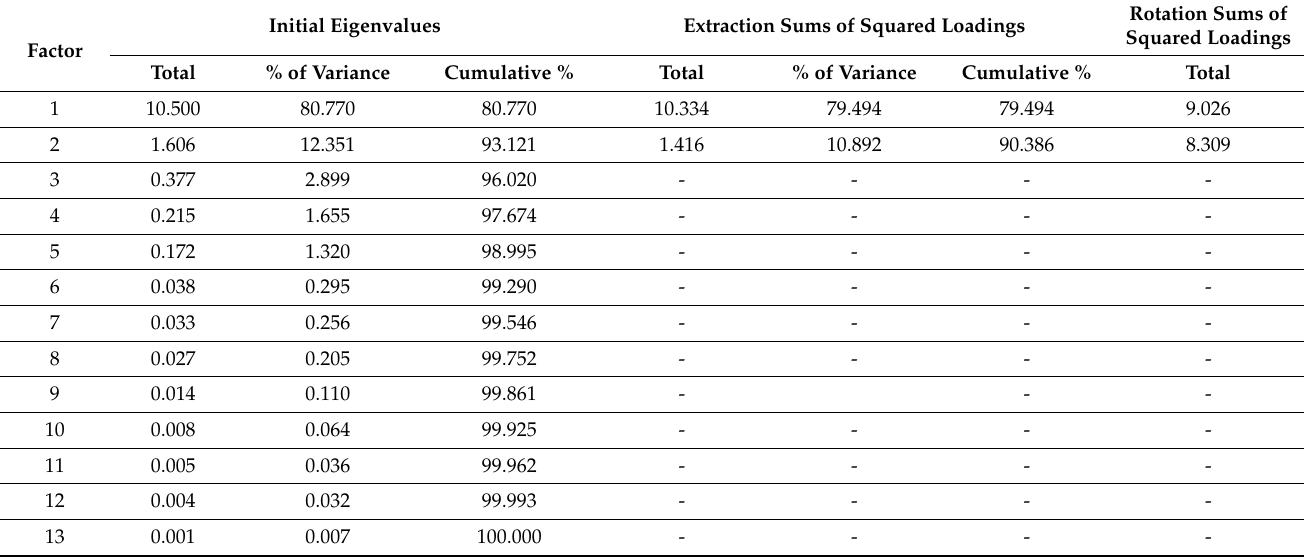
Table 7. Result of eigenvalues and total explained